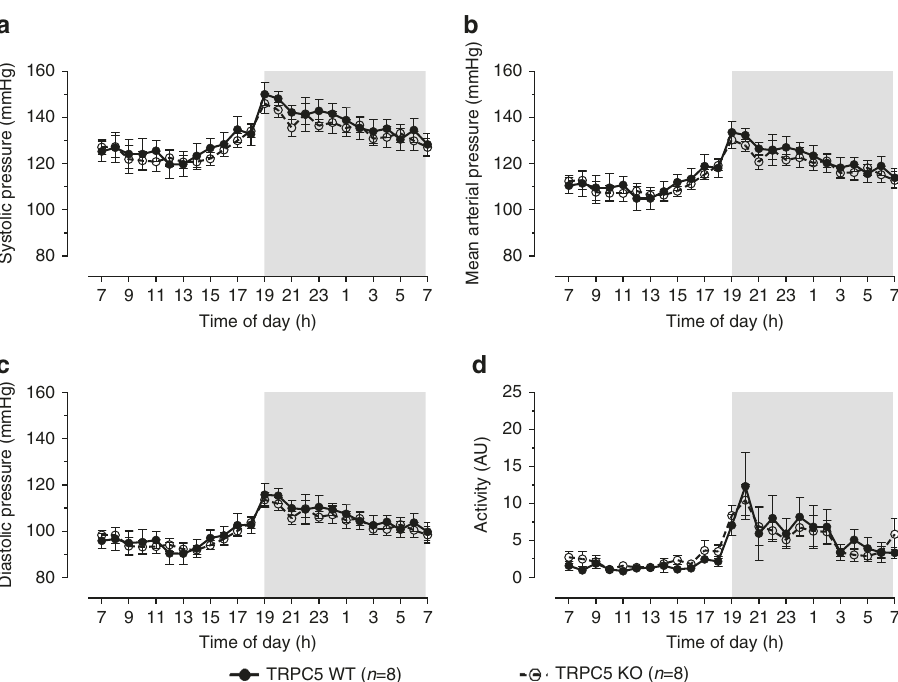
Fig. 1 Blood pressure pro fi ling of WT and TRPC5 KO mice. Conscious measurements of a systolic, b mean arterial and c diastolic pressures, and d activity were taken over the course of 24 h in WT (wildtype) and TRPC5 KO (knockout) mice implanted with a radio-telemetry probe. Shaded regions depict dark- phase recordings. Data shown as hourly averages and expressed as mean ± s.e.m., and analysed by repeated measures two-way ANOVA followed by the Bonferroni post-hoc